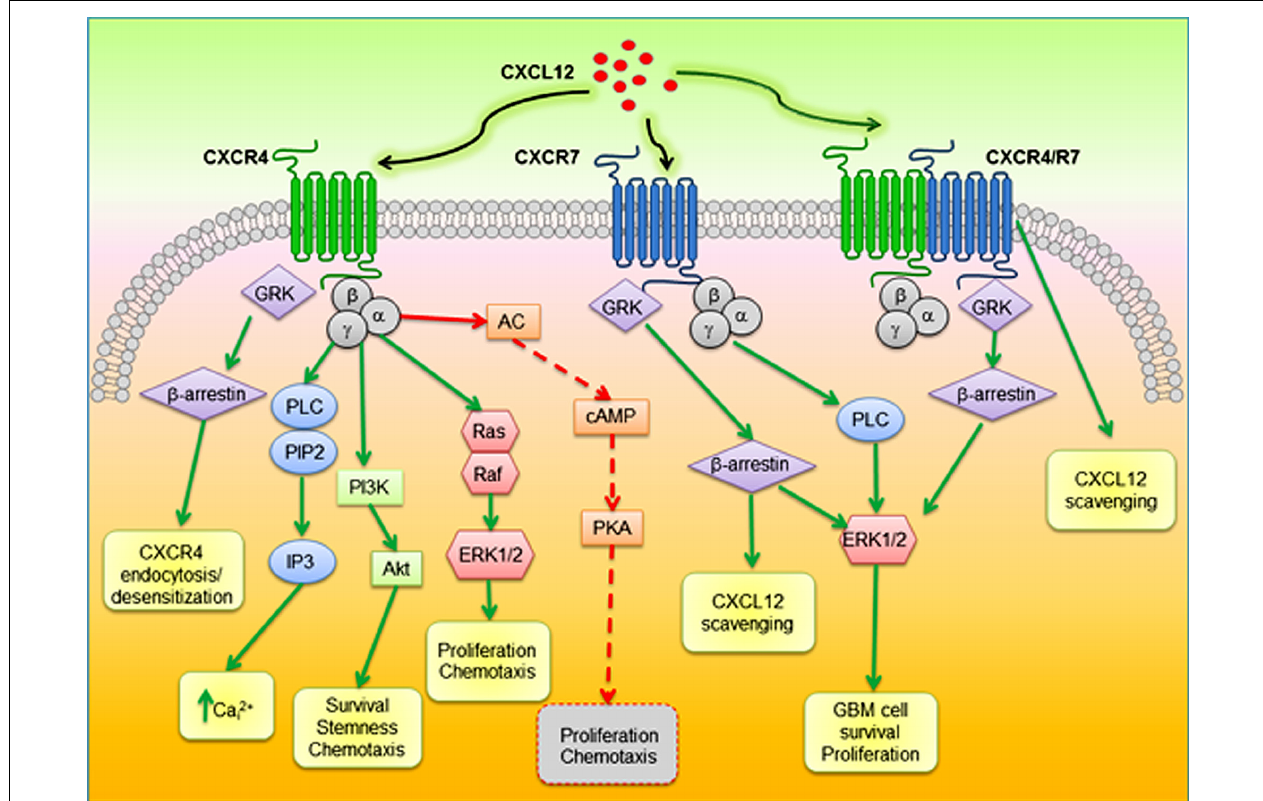
FIGURE 1 | Schematic diagram of proposed CXCR4–CXCR7 crosstalk affecting major signaling pathways related to cell survival, proliferation, and migration. CXCL12 binds to CXCR4 and CXCR7, which can form homodimers or heterodimers. CXCR4–CXCR7 heterodimerization induces a conformational change of CXCR4/G-proteins and blocks signaling. CXCL12–CXCR4 interaction activated by CXCL12 triggers GPCR signaling through PI3K/Akt, PLC/IP3, and ERK1/2 pathways, and mobilization of Ca 2 + from endoplasmic reticulum via inhibition of adenyl cyclase mediated